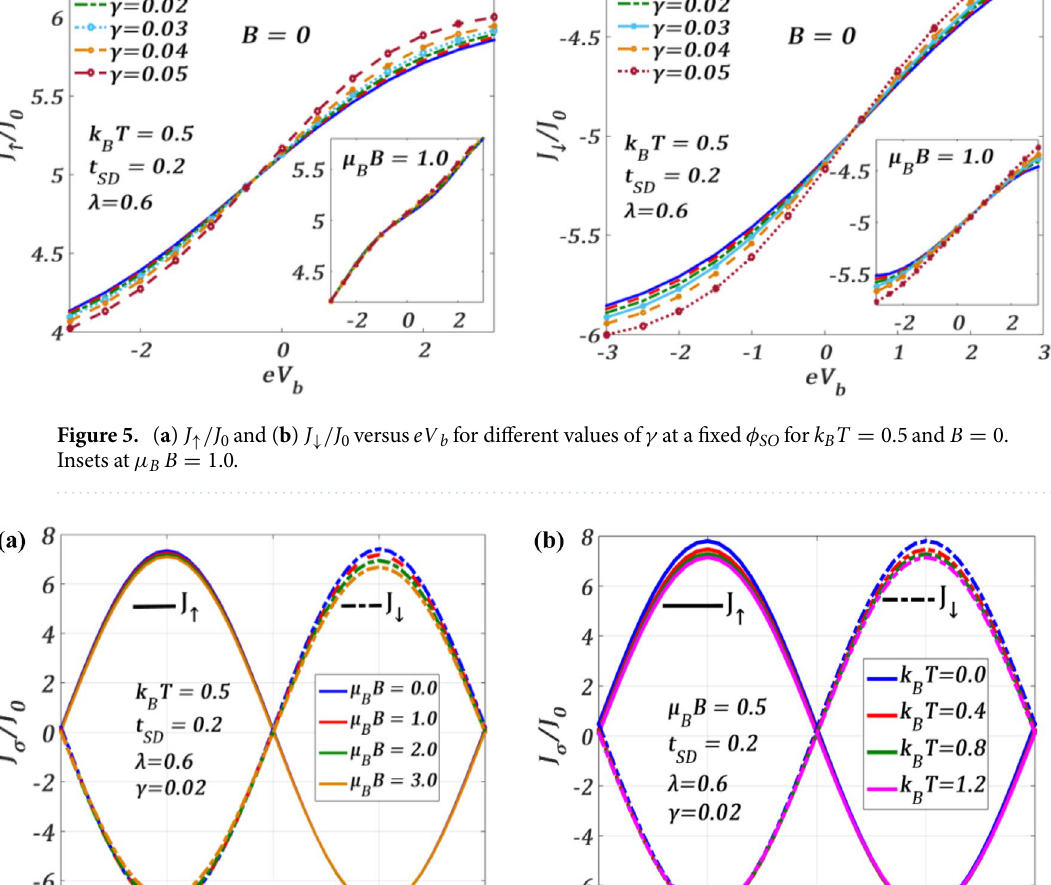
0.6, t SD 0.2, γ 0.02, eV b = = =